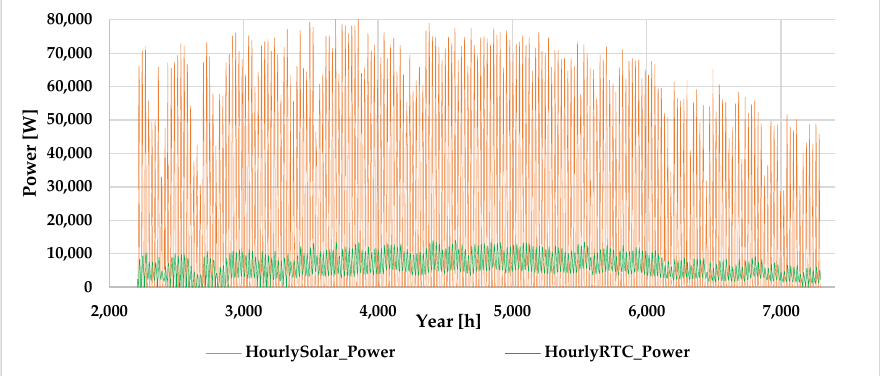
Figure 12. Solar and RTC power trend for the RTC system with Re = 10,000.